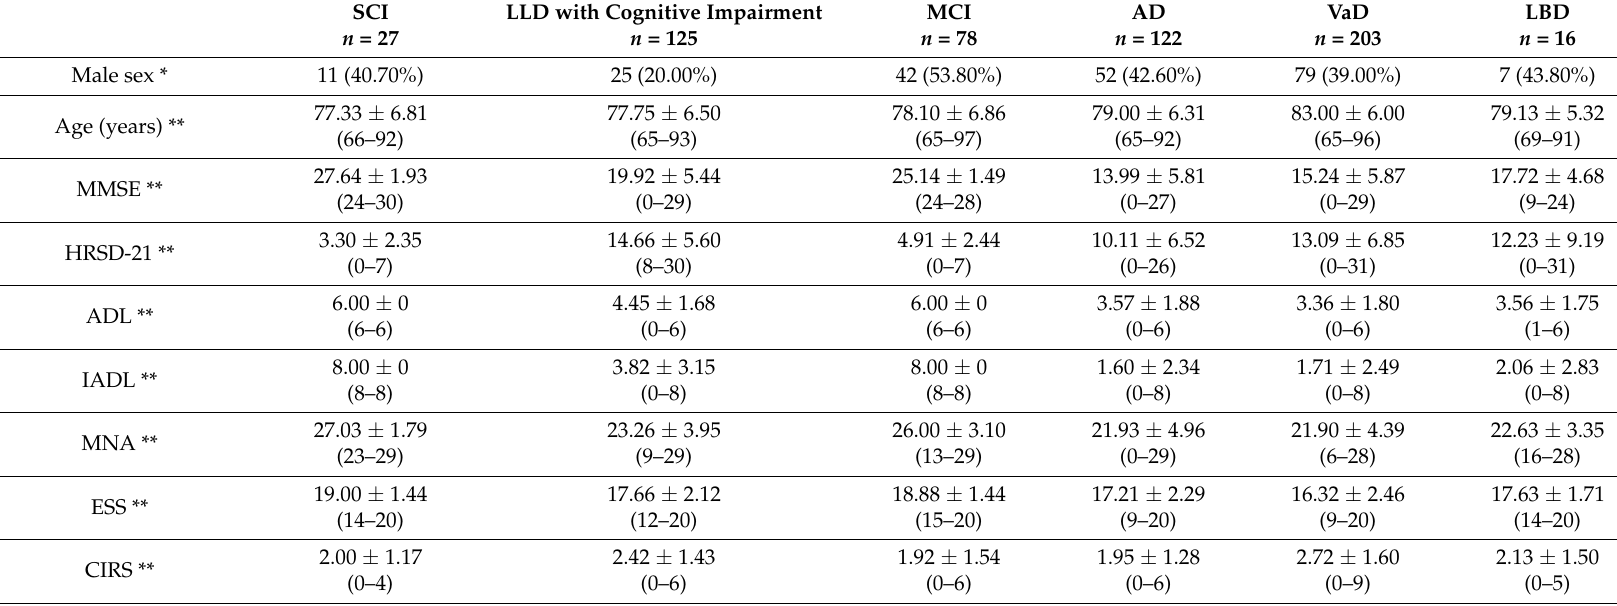
Table 2. Clinical features of patients affected with cognitive decline and/or depression mood